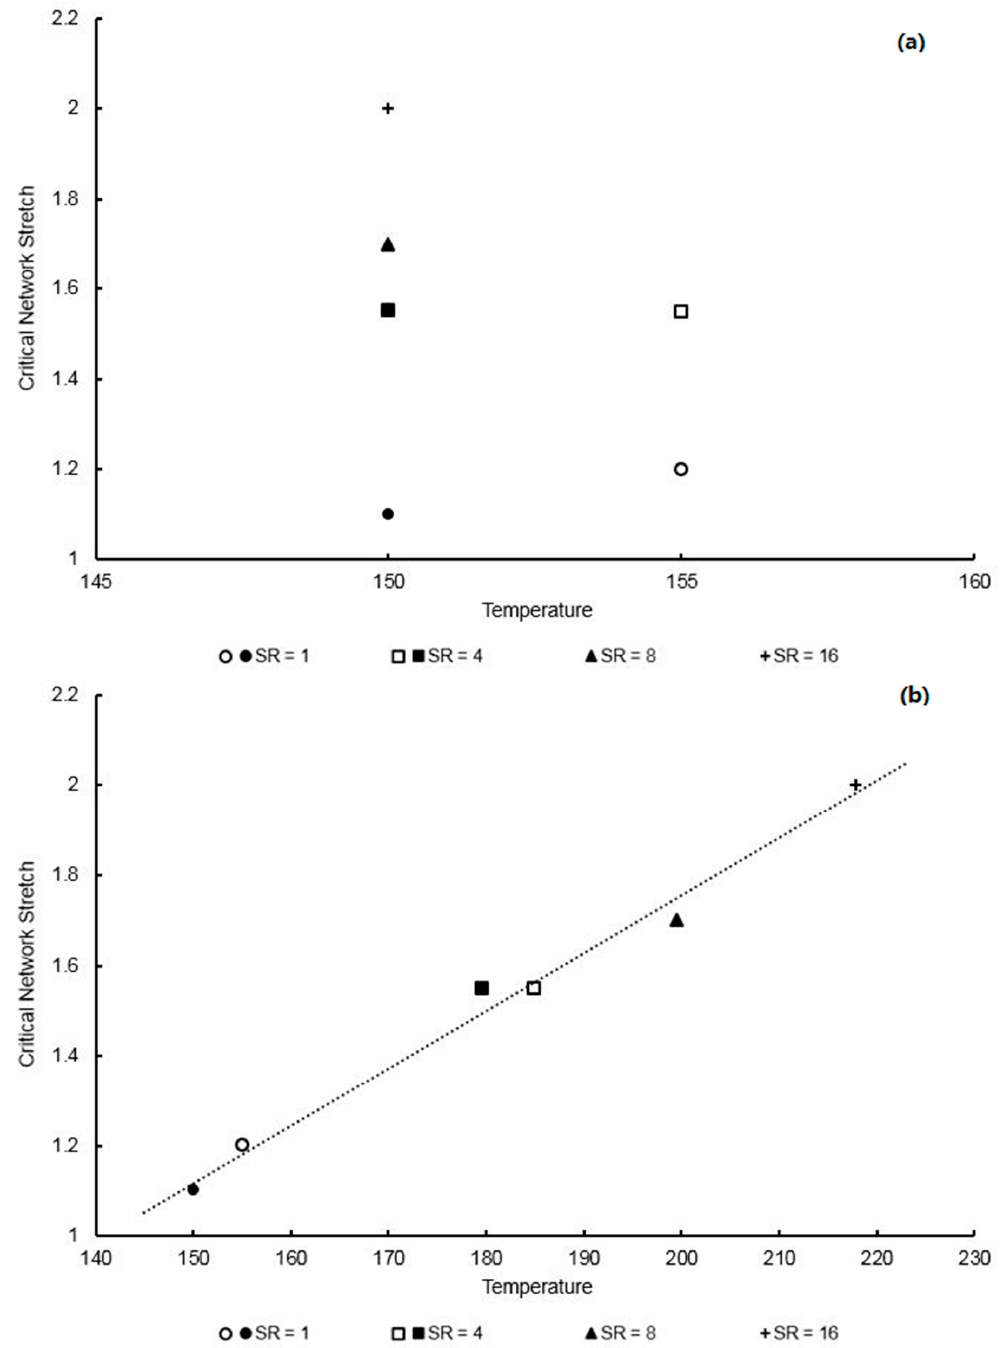
Figure 16. ( a ) Critical network stretch against temperature and ( b ) critical network stretch against shifted temperature following time-temperature superposition (TTS), between strain rates of 1–16 s − 1 for EB stretching in the machine direction.